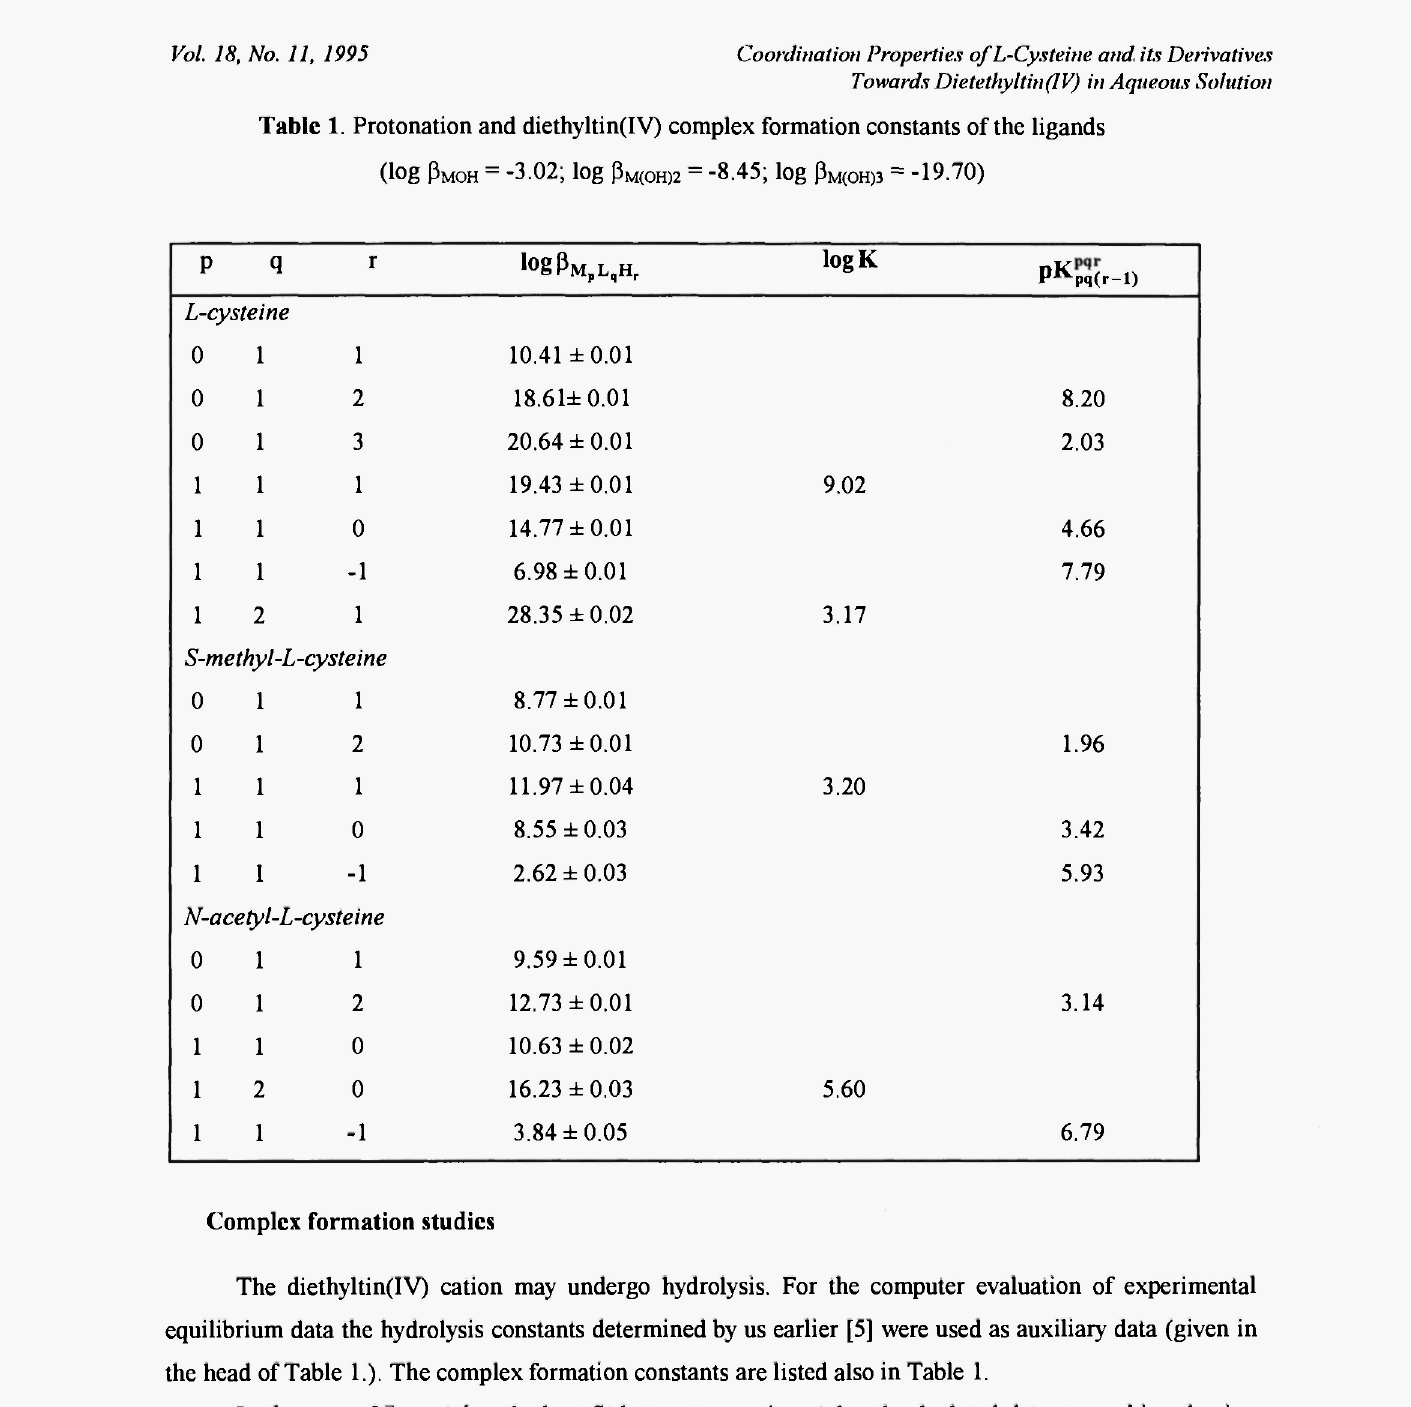
Table 1. Protonation and diethyltin(IV) complex formation constants of the